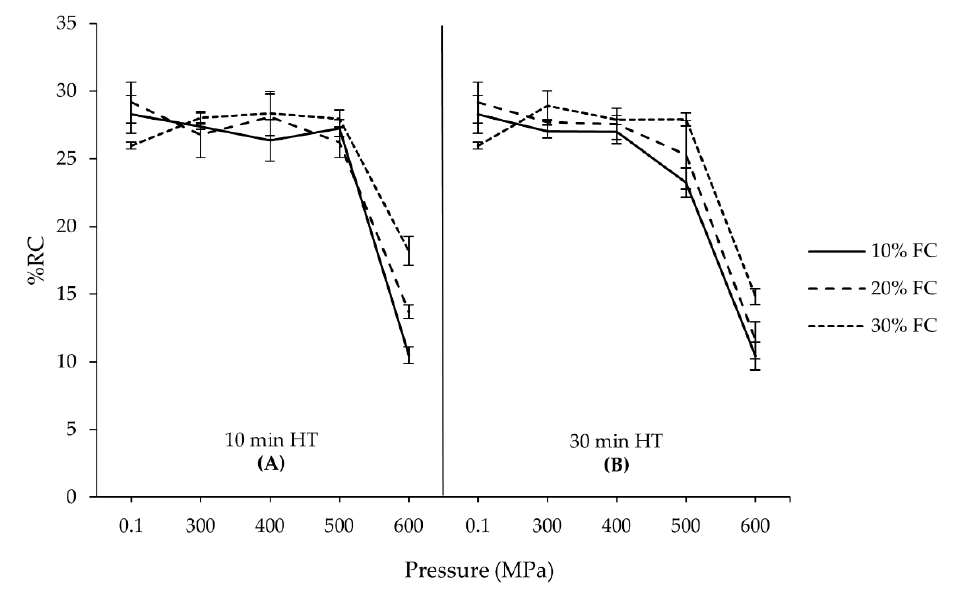
Figure 4. The relative crystallinity percentage (%RC) of untreated (0.1 MPa) and HPP-treated cassava flour at 10 min ( A ) and 30 min holding time ( B ). Error bars represent ± standard deviation (n = 3).